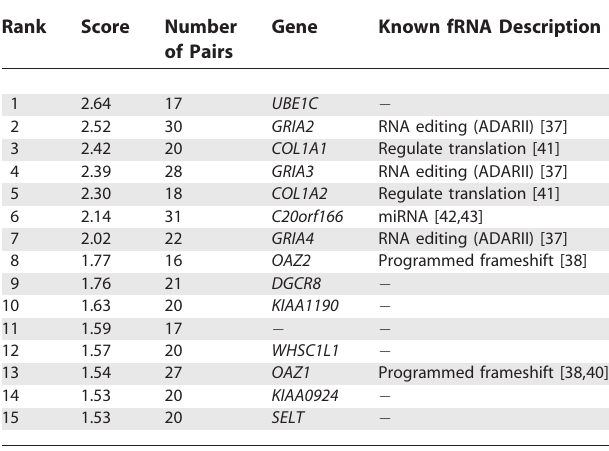
Table 4. Top-Scoring Long-Coding